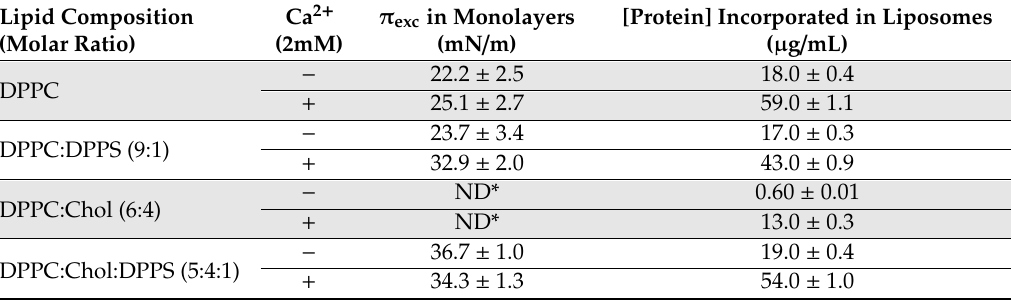
Table 1. Values of exclusion pressure ( π exc ) for lipid monolayers and concentrations of protein incorporated into lipid